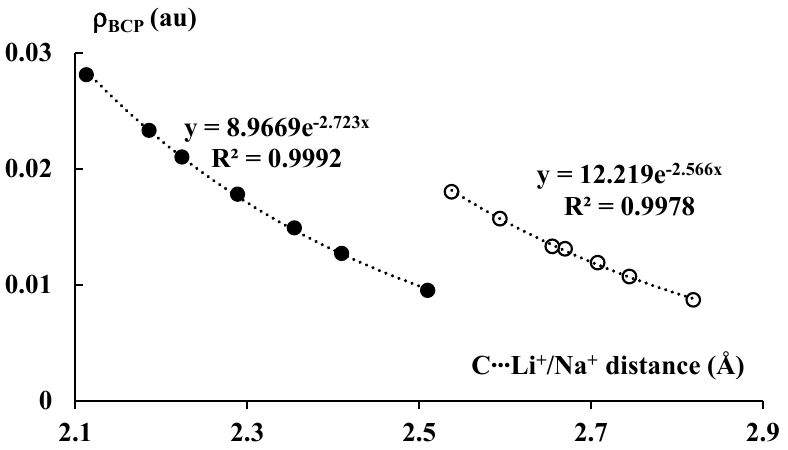
Figure 6. The exponential relationships between the C ··· Li + /Na + distance (in Å) and the electron density (in au) at BCP of the corresponding bond path. The lithium and sodium species are marked by the black and white circles, respectively.